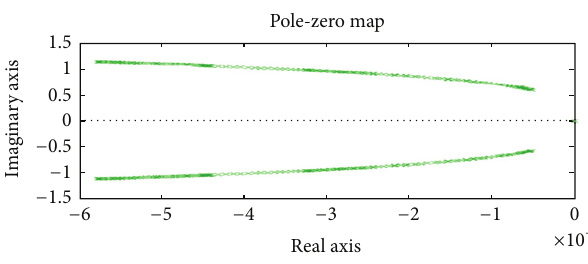
Figure 4: The estimation of the rod length.